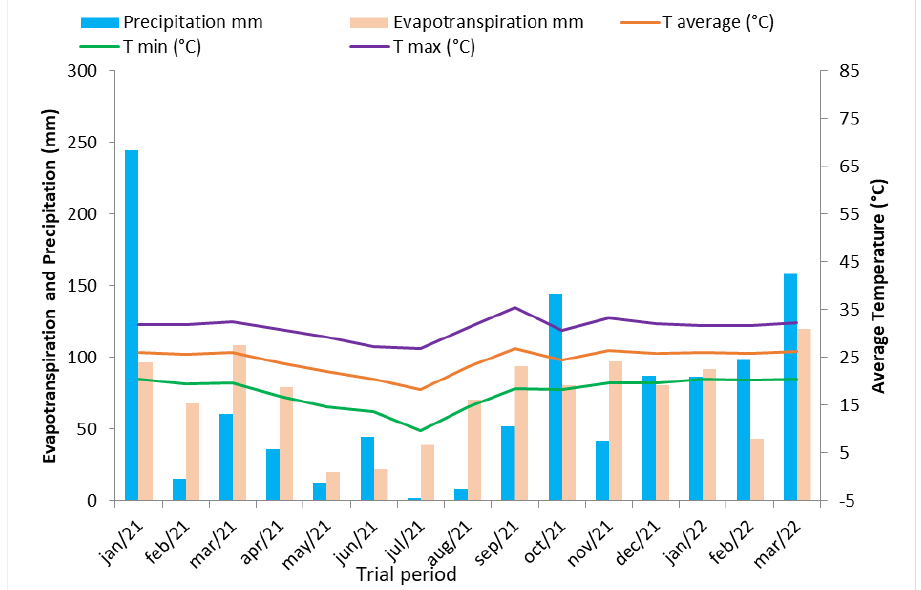
Figure 1. Maximum, average and minimum air temperatures (°C) and monthly accumulated rainfall (mm) during the experiment. (mm) during the